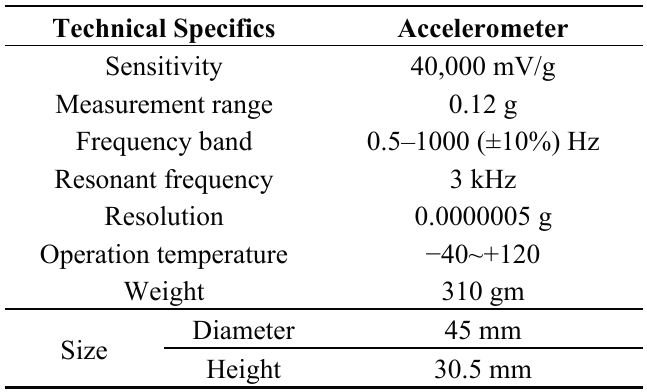
Table 2. Technical specifications of the wired accelerometer.